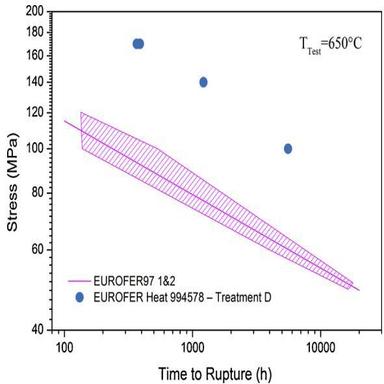
Creep lifetime (time to rupture) for EUROFER in the standard metallurgical condition and after non-standard, optimized heat treatments at T = 650 °C).